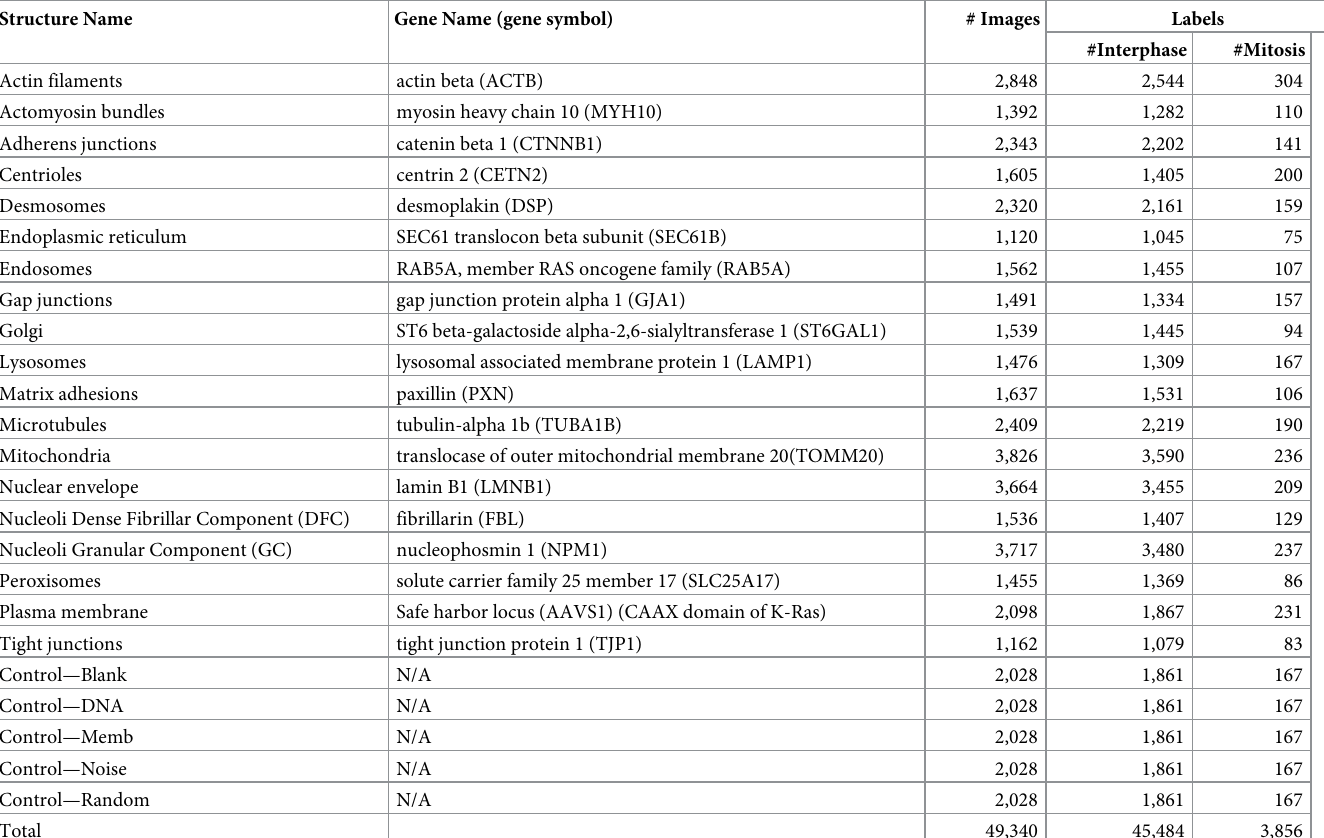
Table 1. Structures used in this study, with corresponding genes, number of images and labels. Each image contains the labeled structure in addition to channels of labeled cell and nuclear